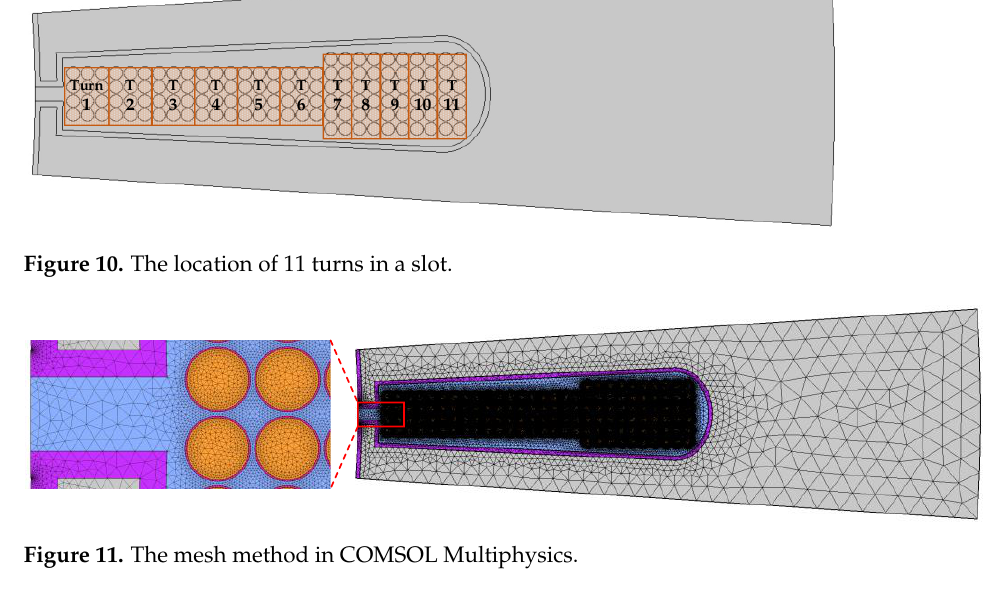
Figure 11. The mesh method in COMSOL Multiphysics.